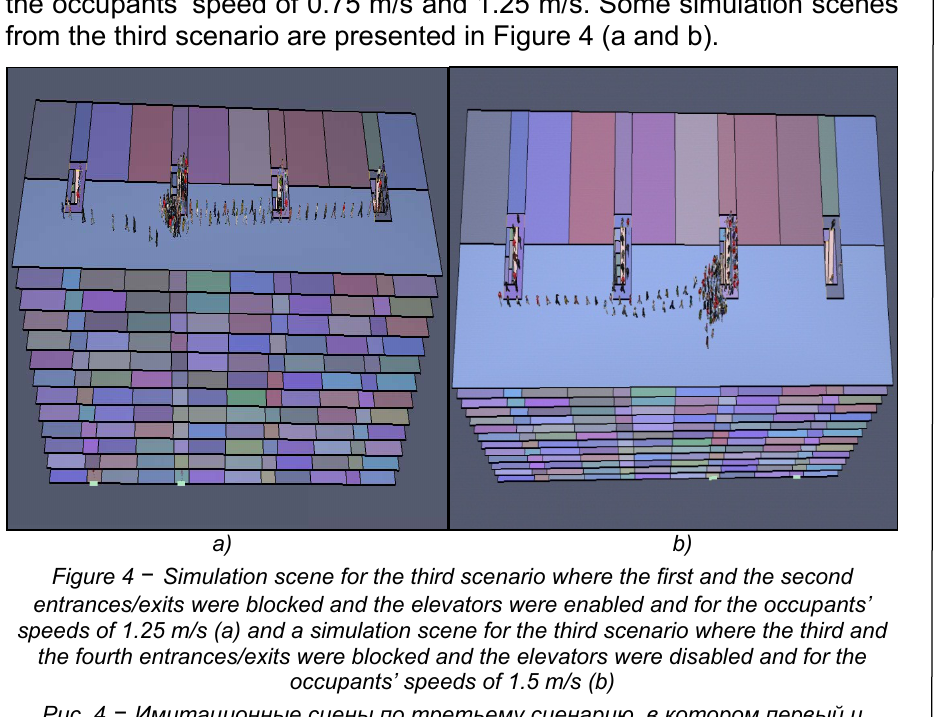
Figure 4 – Simulation scene for the third scenario where the first and the second entrances/exits were blocked and the elevators were enabled and for the occupants’ speeds of 1.25 m/s (a) and a simulation scene for the third scenario where the third and the fourth entrances/exits were blocked and the elevators were disabled and for